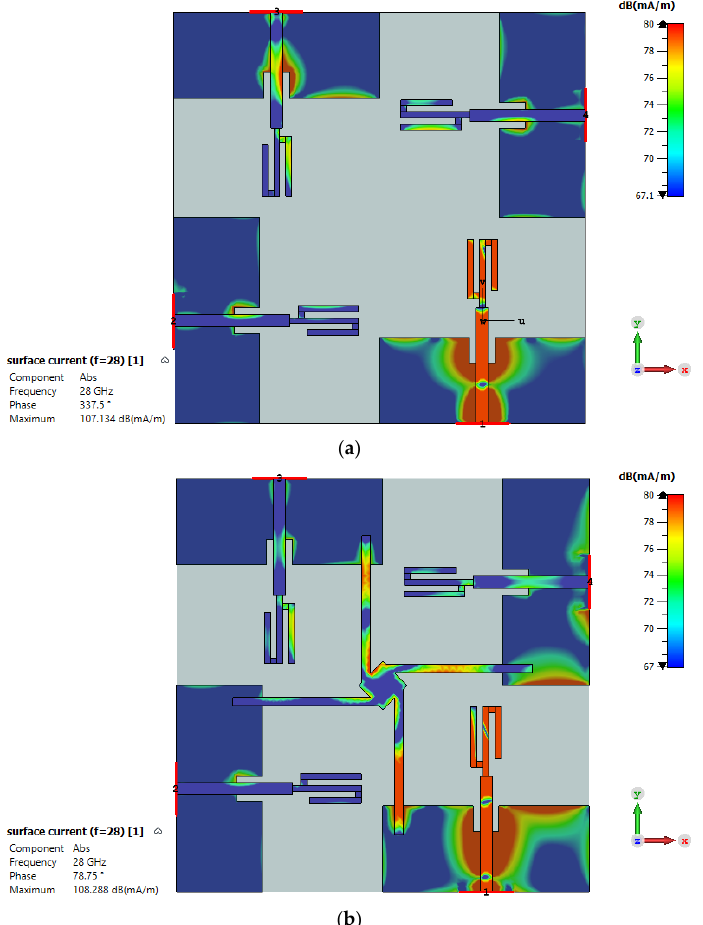
Figure 7. Surface Current Distribution ( a ) Without Isolating Structure ( b ) With Isolating Structure.